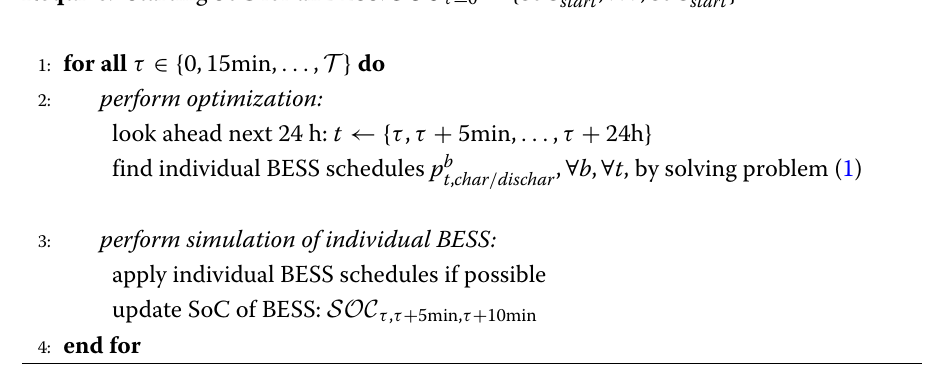
, . . . , SoC n bess start start